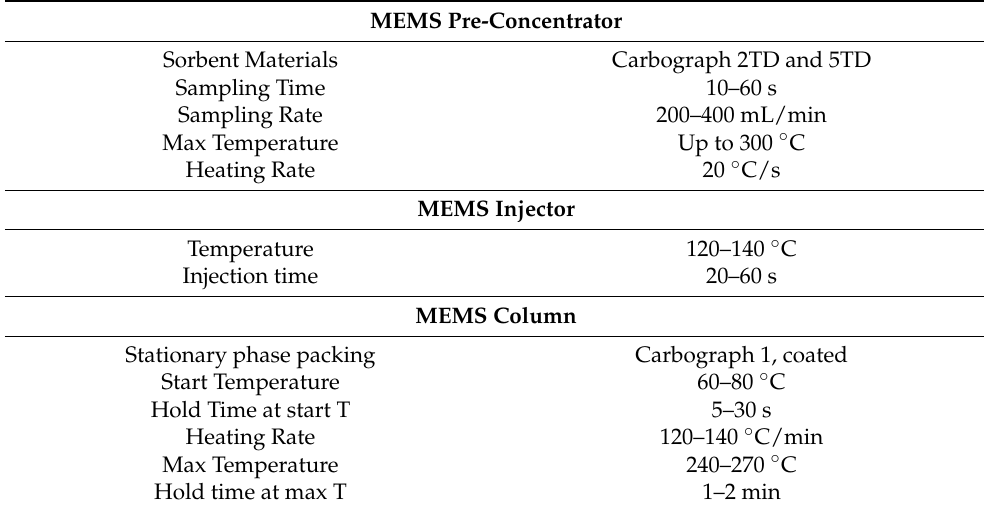
Table 3. Working parameters of the QEPAS analyzer.